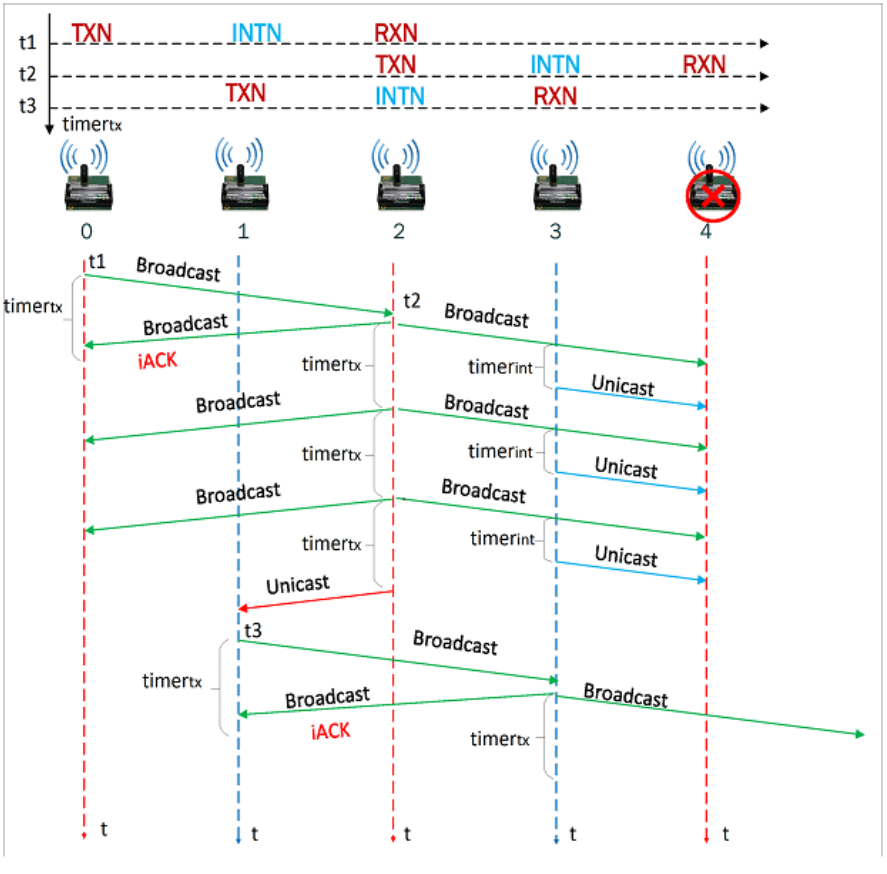
Figure 19. Test with a failing node.